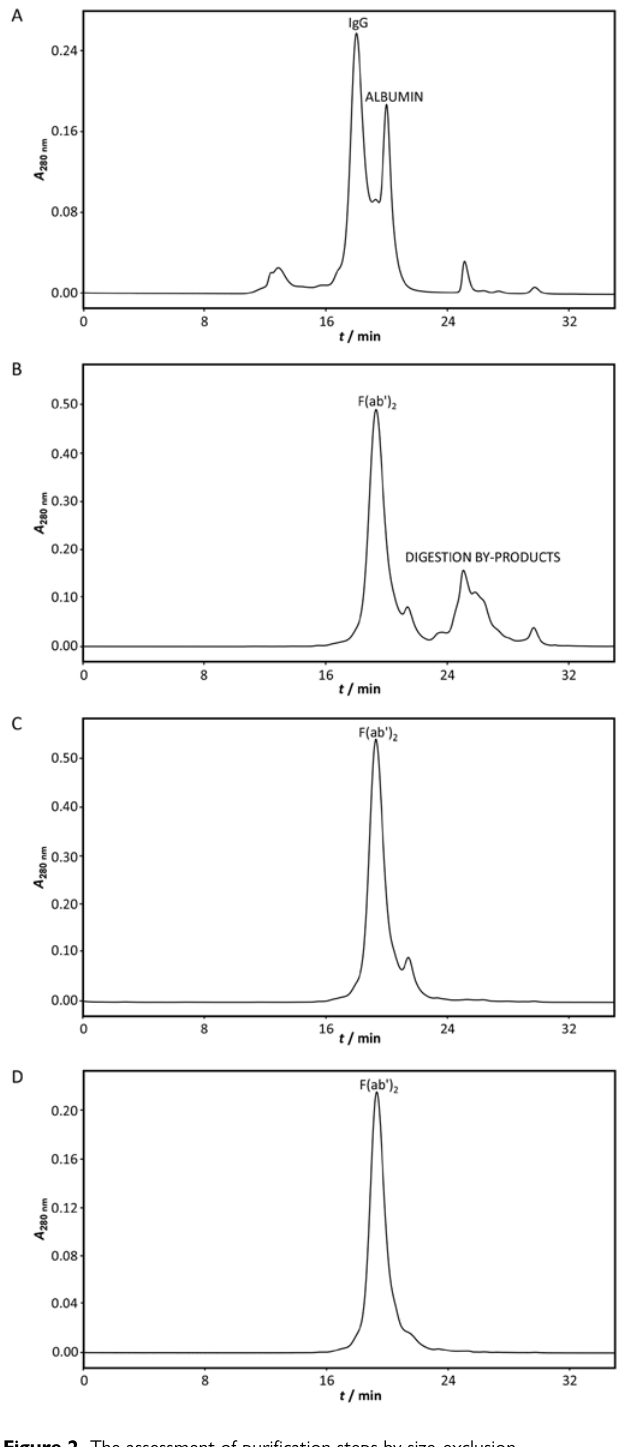
Figure 2. The assessment of purification steps by size-exclusion chromatography. The analysis was performed on a TSK-Gel G3000SWXL column (7.8 × 300 mm) with 0.1 M phosphate-sulfate running buffer, pH 6.6, at a flow rate of 0.5 mL min -1 . The sample (2 mg mL -1 ) was loaded to the column in a volume of 50 μL per run. (A) Heat-treated plasma. (B) F(ab’) fraction obtained by simultaneous 2% caprylic acid ( V / V ) precipitation 2 and pepsin digestion before (crude IgG) and (C) after diafiltration using a 50 kDa membrane (pure IgG). (D) Ultrapure F(ab’) preparation – flow- 2 through fraction from anion-exchange chromatography performed at pH 5.0. Detection: UV at 280